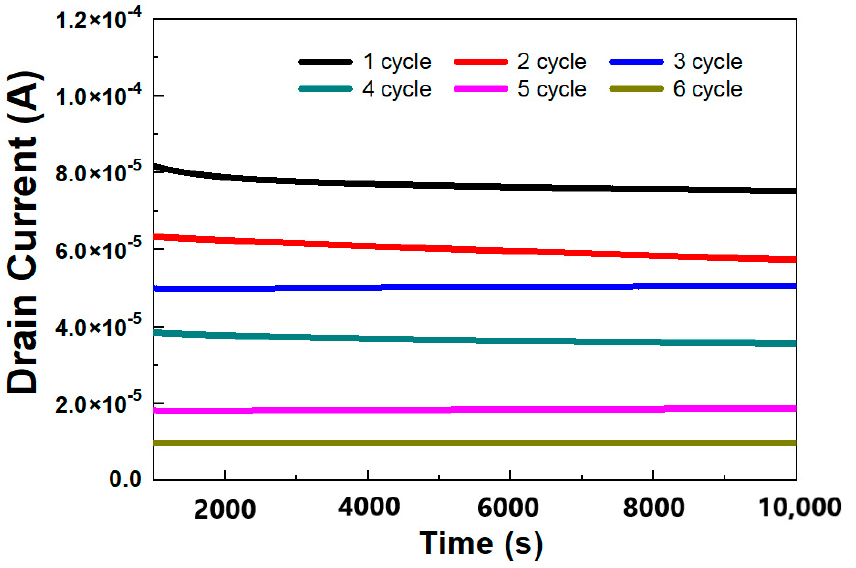
Figure 3. Variation in drain current for 10,000 s. From the metallic state, multiple states were formed by several negative pulses with each state maintaining a constant value under a drain voltage of 1 V by fixing V G to 0 V.